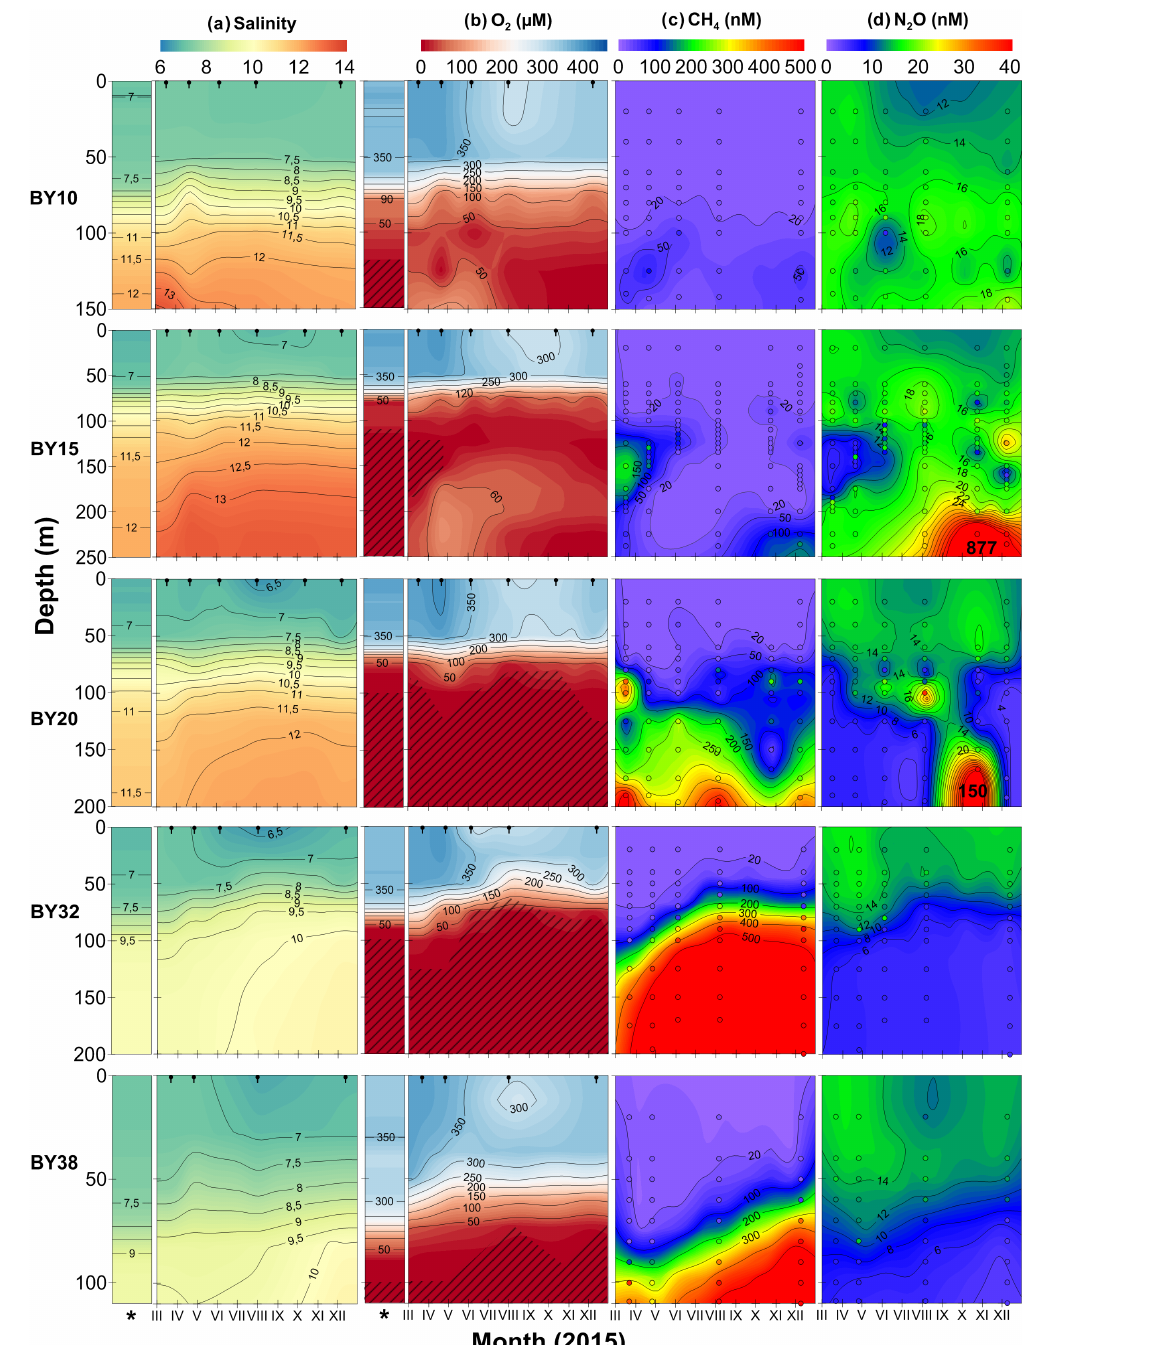
Figure 2. Bilinearly interpolated profiles of (a) CTD salinity, (b) CTD oxygen (µM, shading denotes presence of H 2 S), (c) [CH 4 ] (nM) and (d) [N 2 O] (nM) from all sampling stations at all sampling times of the survey. The x axis covers the period 17 March to 13 December 2015. Black notches in (a, b) indicate sampling dates, while the narrower bars marked with an asterisk represent conditions in June 2014, prior to the MBI. Circles in columns (c, d) represent gas sampling depths and times, while infill colour is the non-interpolated original concentration. Note that all CH 4 and N 2 O data below the cut-off were set to cut-off prior to interpolation (see Supplement S1 for